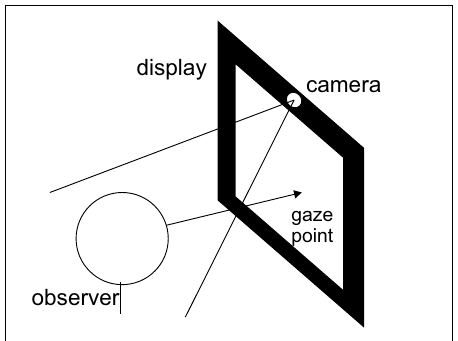
Figure 1. The experimental